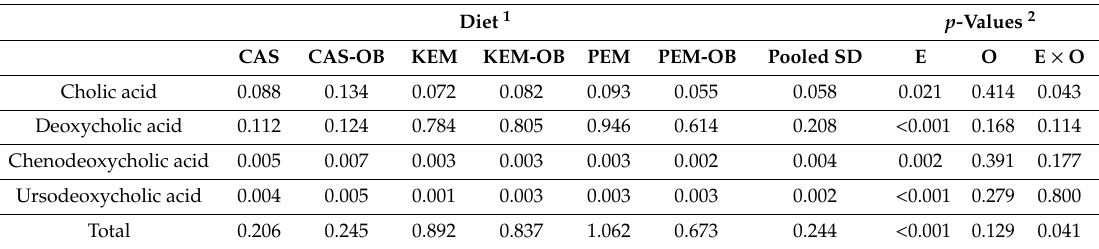
Table 5. Bile acids concentrations ( µ mol / g) in the feces of rats fed casein or casein plus extruded mix diets either obesogenic or not.